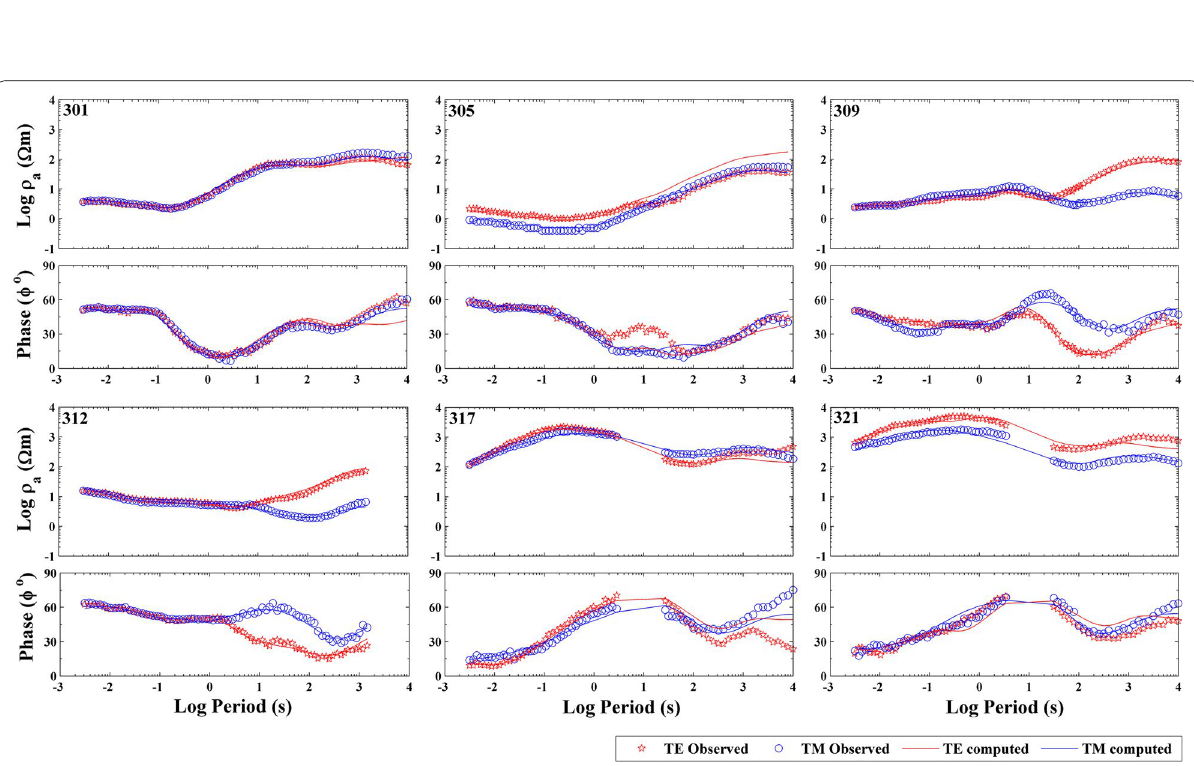
Fig. 9 2-D inversion data fit to the observed data and computed responses for representative stations. Open red star represents TE observed response, open blue circle represents TM observed response, red solid line represents TE computed response, and the blue solid line represents TM computed